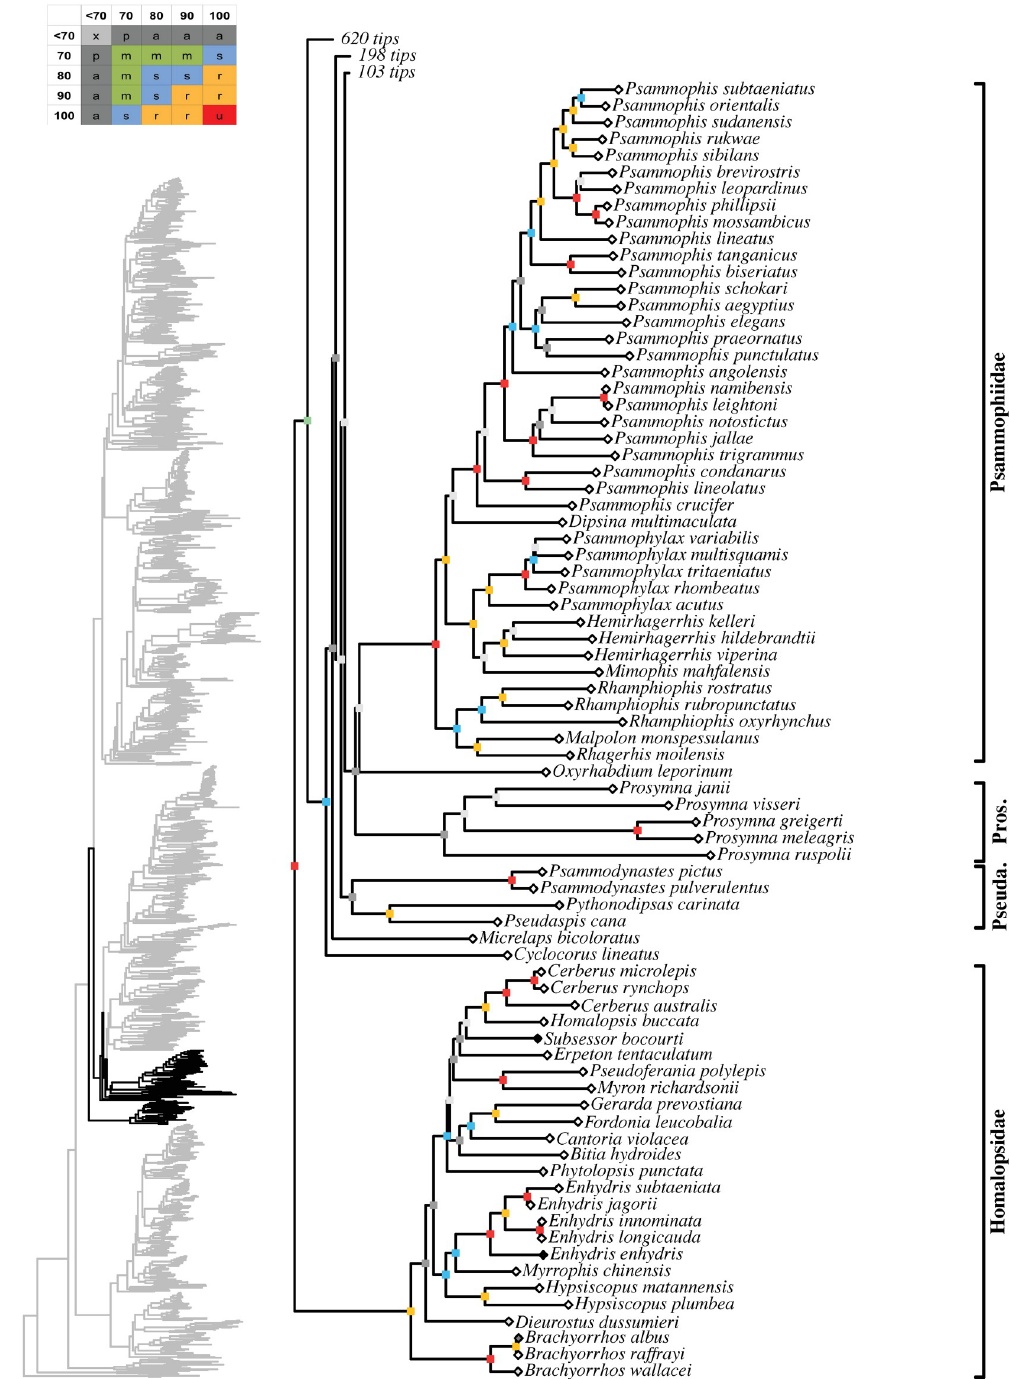
Fig 10. Maximum likelihood species-level phylogeny of Colubroides (continued). Basal Elapoidea, families Homalopsidae, Cyclocoridae, Pseudaspididae, Psammophiidae.